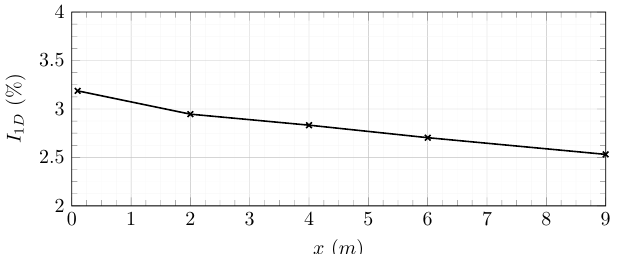
Figure 10. Turbulence rate I 1 D at the centre of the LBM domain using DFSEM with L = 1.0 m and = 8.928 × 10 − 4 m 2 .s − 2 . x is the distance from the inlet of the LBM domain. u (cid:48) 2 i